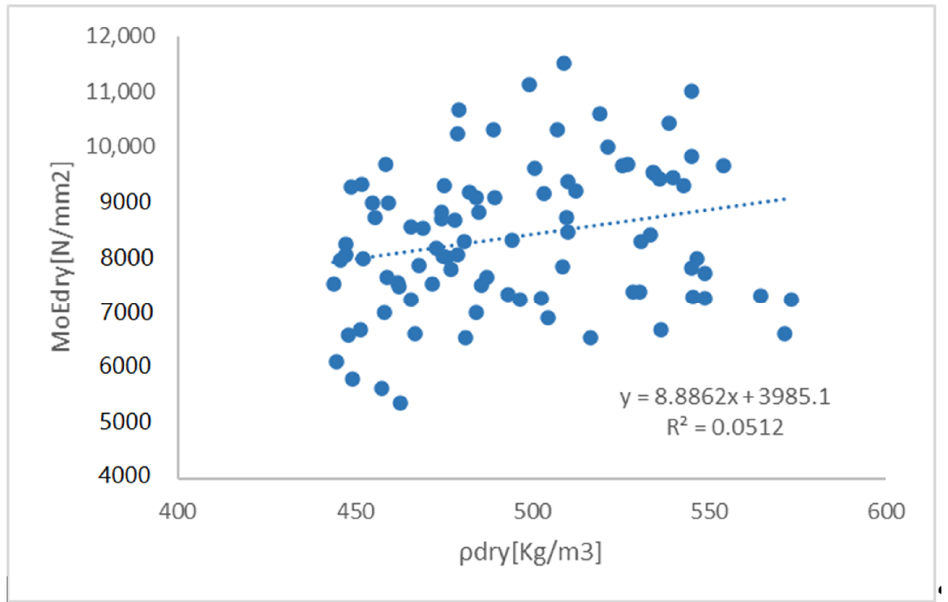
Figure 9. MoE dyn vs. wood density ρ—Dry condition.